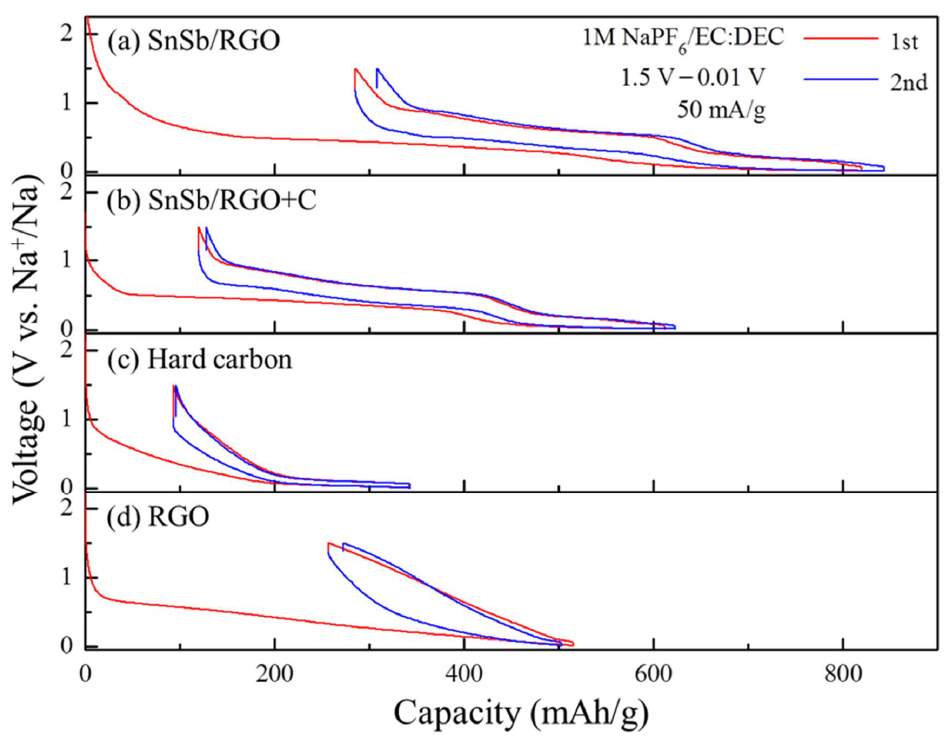
Figure 2. Voltage profiles of ( a ) SnSb/RGO, ( b ) SnSb/RGO+C, ( c ) hard carbon, and ( d ) RGO.